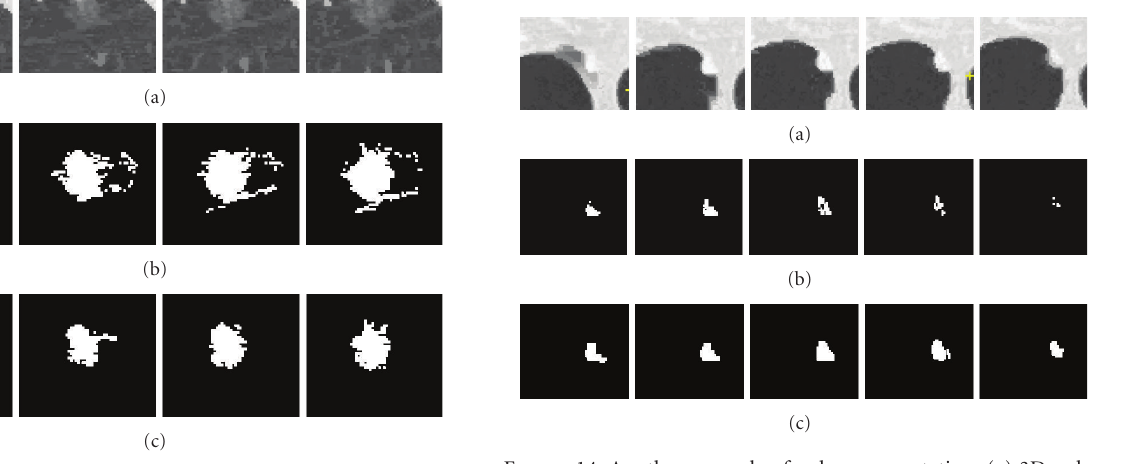
Figure 12: An example of a large GGO nodule segmentation. (a) Original 3D nodule on eight contiguous slices; (b) and (c) segmentation results without and with shape feature (proposed method), respectively.